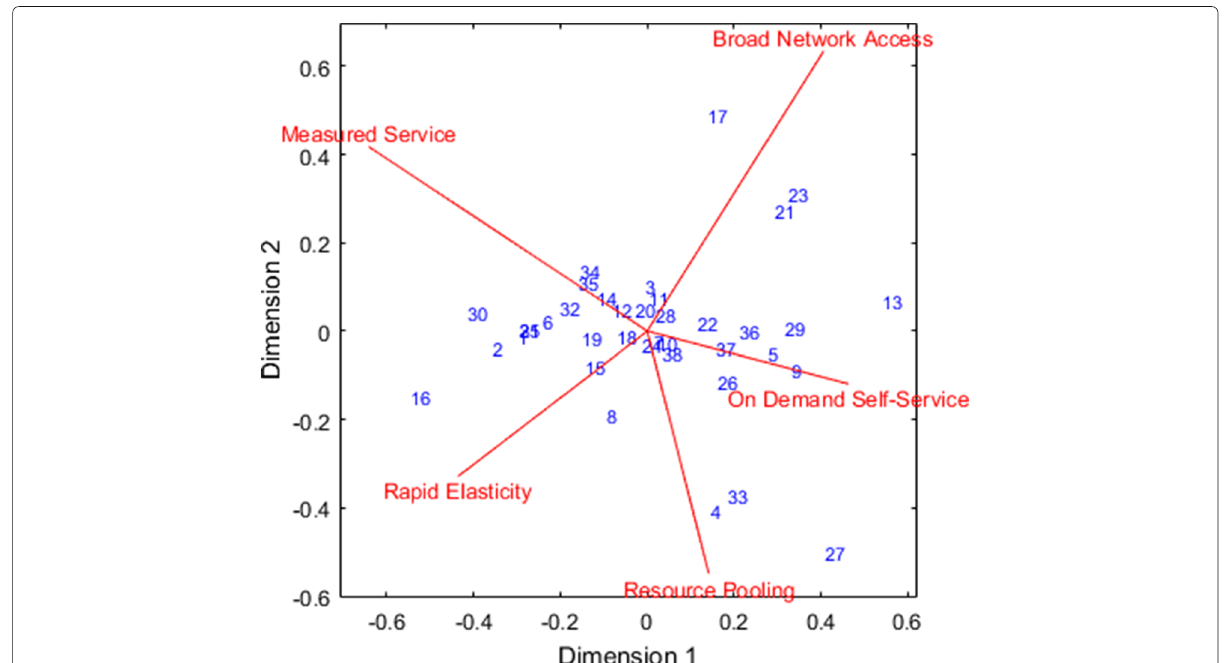
Fig. 4 2-dimensional biplot of the 5-dimensional partitioned dataset of the Essential Characteristics. Here MeasuredService and BroadNetworkAccess are slightly dominant in the solution, but perhaps insignificantly. BroadNetworkAccess is driven largely by cases 17, 21 and 23, ResourcePooling by cases 27, 4 and 33, MeasuredService and RapidElasticity jointly by a larger set of cases, in decreasing significance, 16, 2, 30, 1, 31, 25, 6 and 32. The cluster of cases 13, 29, 9, 5, 36, 37, 26 and 22, drives OnDemandSelfService . The remaining cases close to the centre form a distinct cluster of similarity, but do not contribute significantly to the 2-d solution